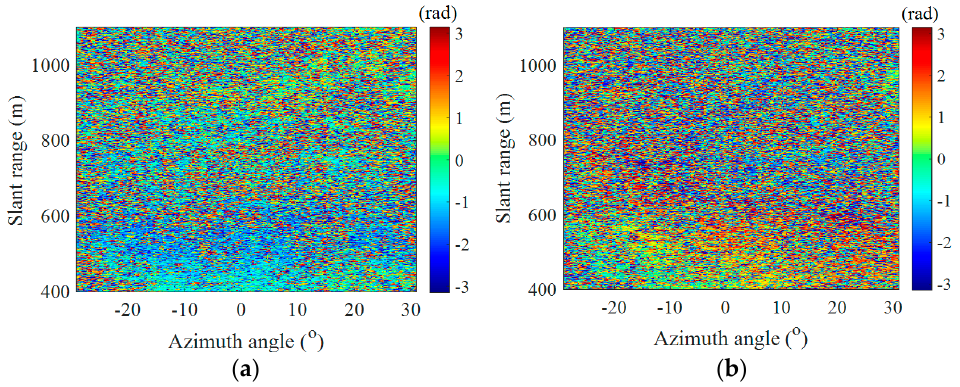
IM . Figure 10. ( a ) Phase interferogram IM 1 30